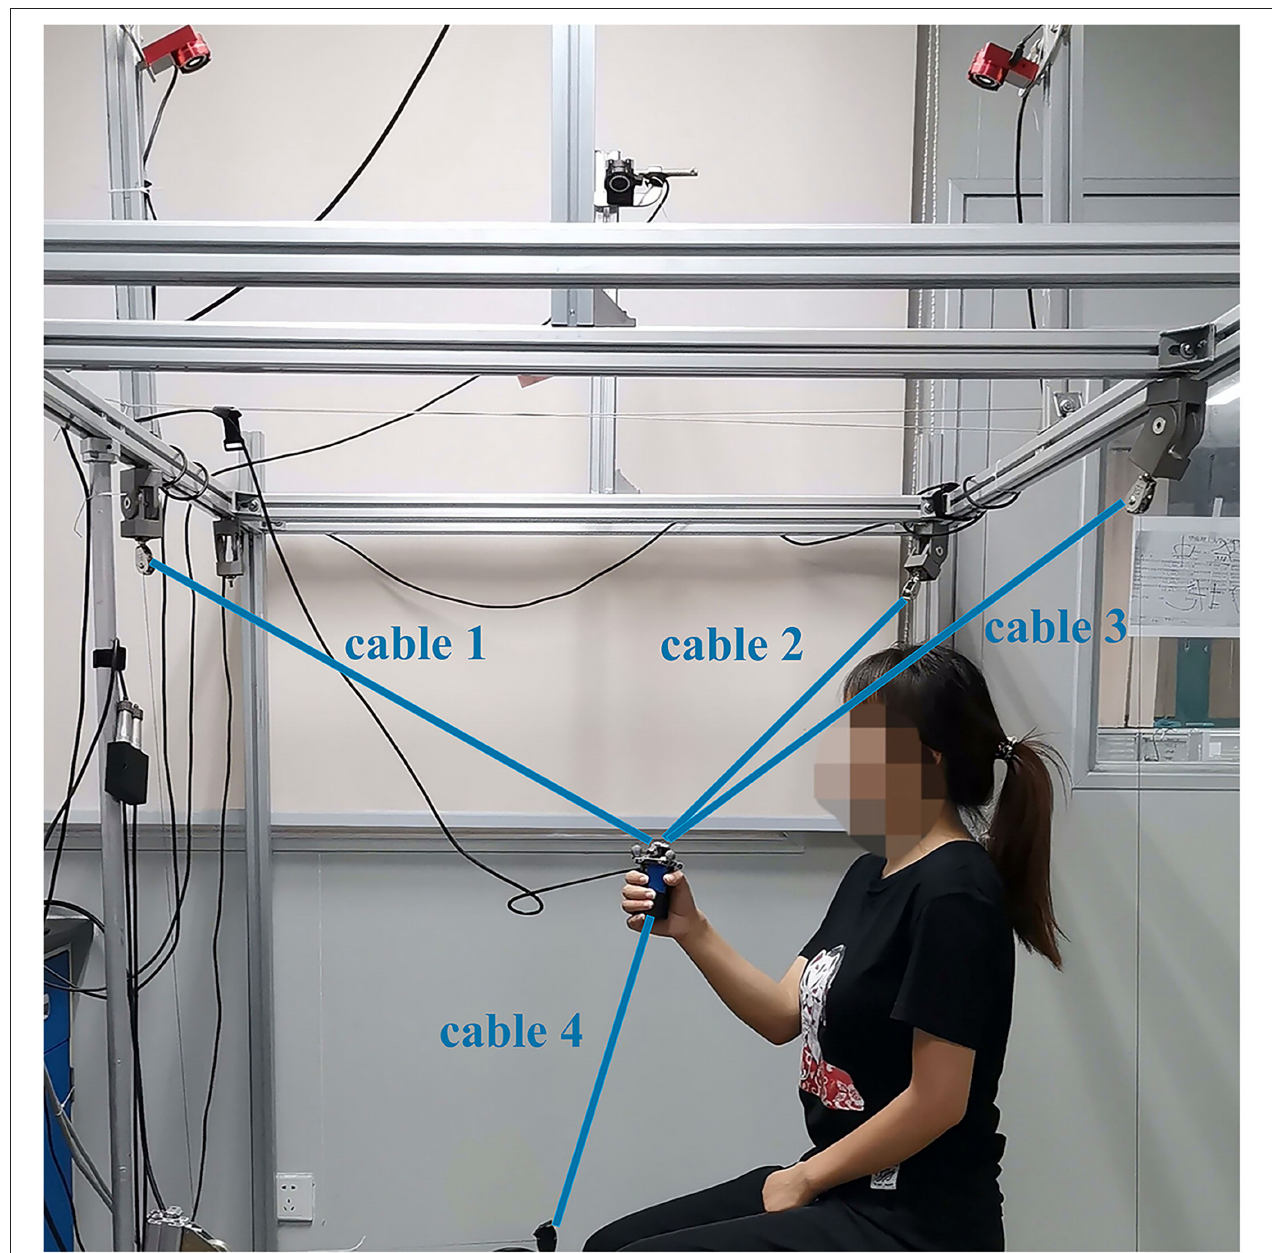
FIGURE 1 | The schematic representation of the cable-driven rehabilitation robot (CDRR).